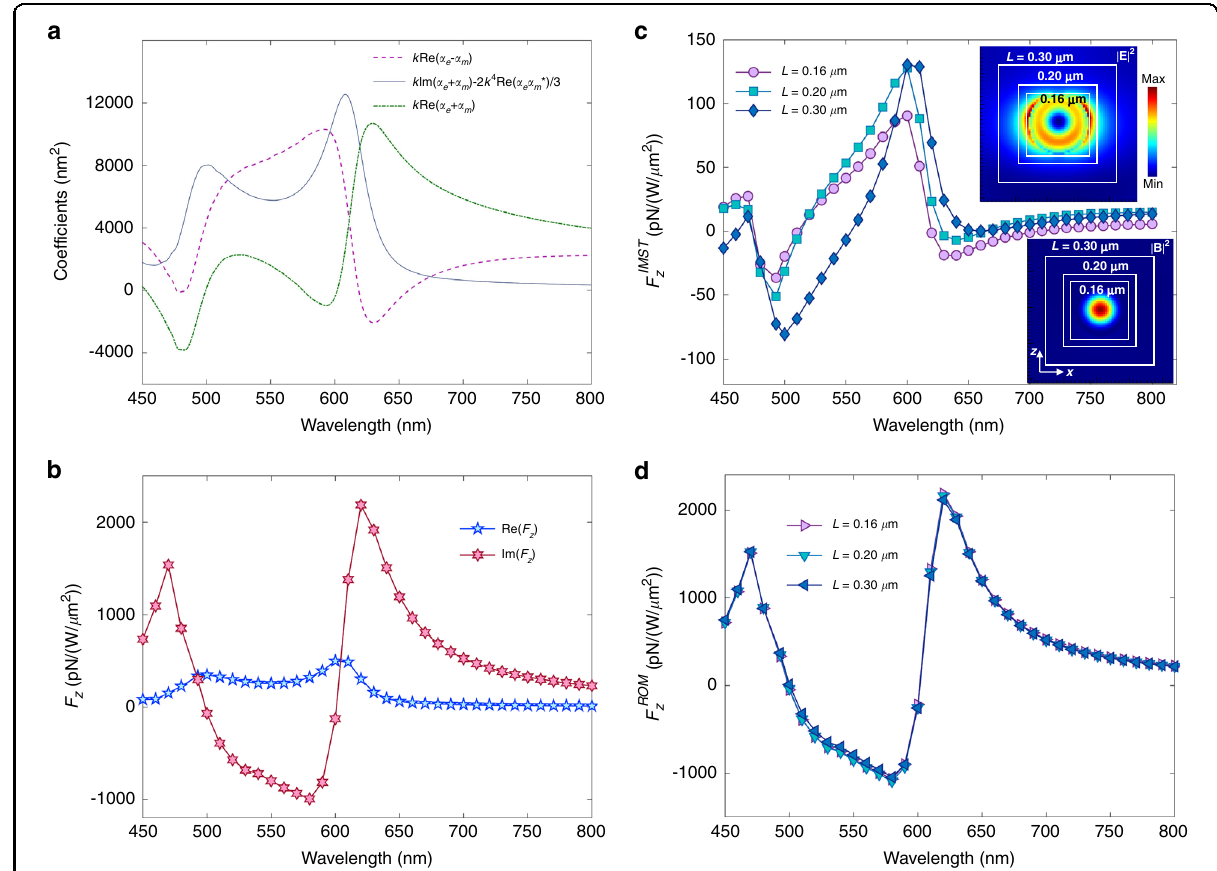
Fig. 3 Linearly polarized propagating plane wave incident on a Si sphere of radius a = 75 nm. E 0 = 1. a Combined polarizabilities calculated via Mie theory. The expression of < F z > given by these polarizabilities according to ref. 38 is shown in the full line, while the broken one depicts the theoretical fl ow IMST, F IMST , component of the reactive force, F I , according to Eq. (55). b Numerical results for the time-averaged force < F z > and z z on the sphere. c IMST component, F IMST , of the ILF numerically calculated with different cube integration contours. Insets show maps reactive force F I z z on the x = 0 plane of ∣ E ∣ 2 and ∣ B ∣ 2 at λ = 610 nm which corresponds to the magnetic dipole resonance. White broken line squares illustrate the integration contours. d ROM component, F ROM , of the ILF calculated by subtracting F IMST from F I z z